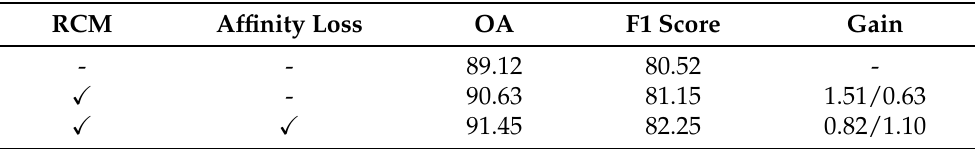
Table 3. Ablation analysis of RCM and affinity loss on the Fuzhou testing dataset.